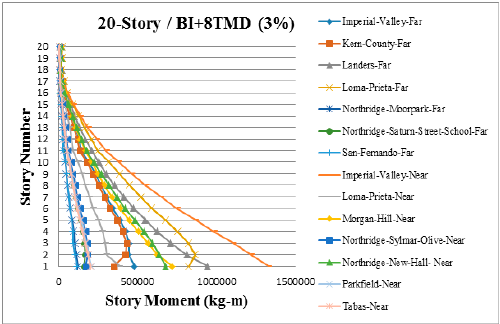
Figure A28. Peak story moments for 20-story base-isolated building with 8 TMDs.